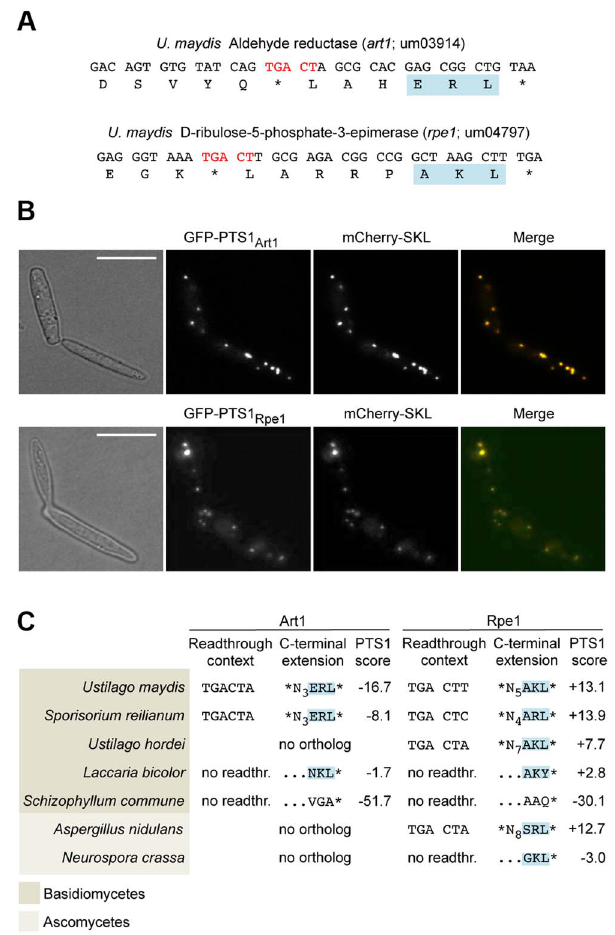
Figure 2. Peroxisomal targeting of NADH-dependent aldehyde reductase Art1 and D-ribulose-5-phosphate-3-epimerase Rpe1 is conserved in fungi. (A) 3 9 sequences of U. maydis genes art1 and rpe1 together with their derived polypeptide sequence. PTS1 and readthrough elements are highlighted. All accession numbers are from MIPS Ustilago maydis DataBase (MUMDB). (B) The PTS1 motifs of Art1 and Rpe1 were fused to GFP and co-expressed with the peroxisomal marker mCherry-SKL in U. maydis cells. BF indicates bright field. Scale bars represent 10 m m. (C) Conservation of readthrough derived peroxisomal isoformsof Art1 andRpe1orthologsinfungi. Predictions were carried out with a PTS1 predictor [66]. In some organisms the PTS1 is part of the original open reading frame indicated by no readthr. and …NNN*.